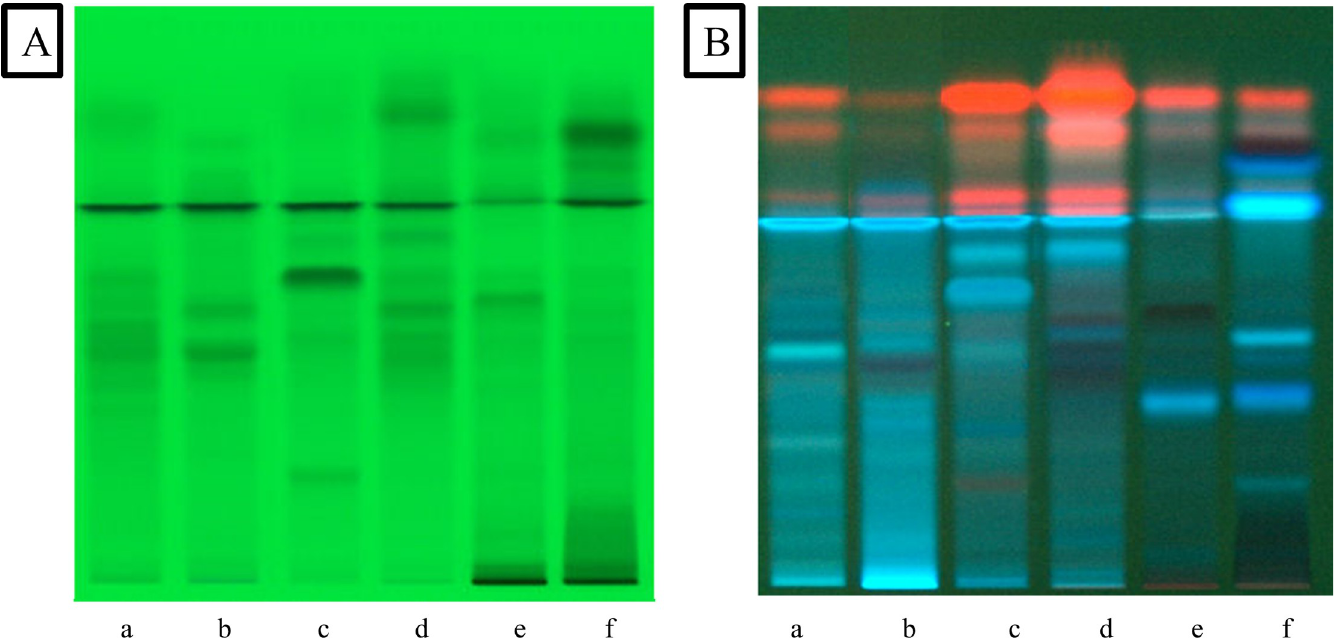
Fig 2. HPTLC chromatograms of (a) R . officinalis , (b) S . sclarea , (c) O . vulgare , (d) T . longicaulis , (e) C . creticus and (f) C . monspeliensis at 254 nm ( A ) and 366 nm ( B ) (mobile phase ethyl acetate, methanol, formic acid, water (50:10:7:1; v/v/v/v)).